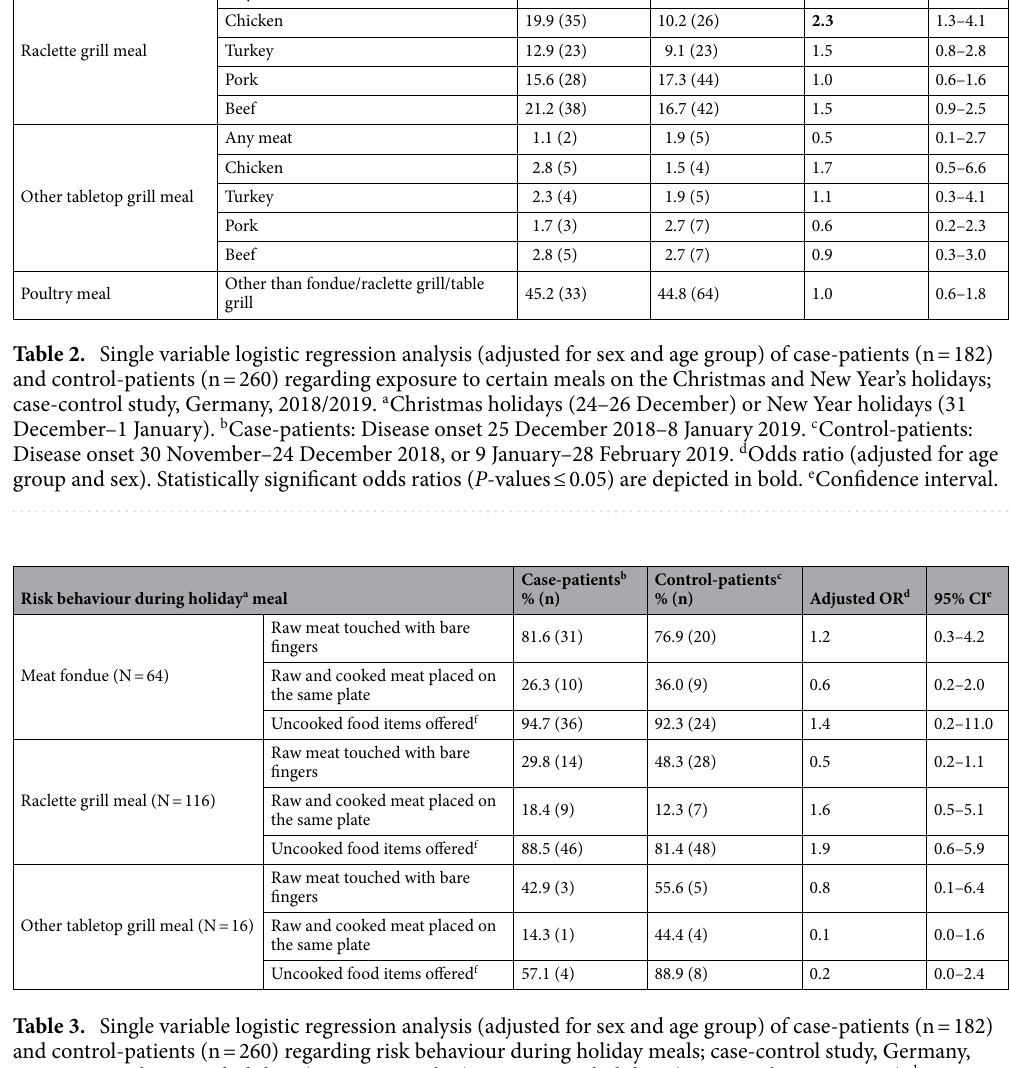
Table 3. Single variable logistic regression analysis (adjusted for sex and age group) of case-patients (n = 182) and control-patients (n = 260) regarding risk behaviour during holiday meals; case-control study,